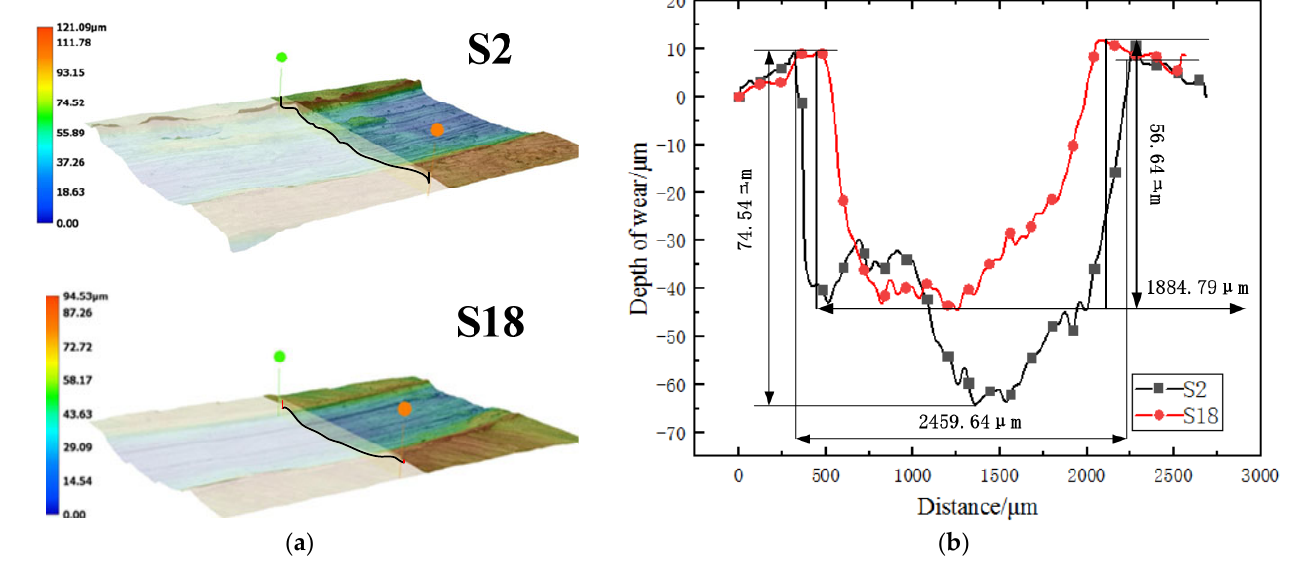
Figure 9. Wear section profile of specimen. ( a ) Three-dimensional contour map. ( b ) Wear section depth curve.